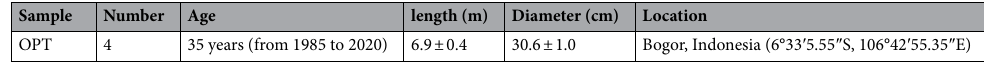
Table 1. Basic information of unproductive oil palm trunks used in this experiment.